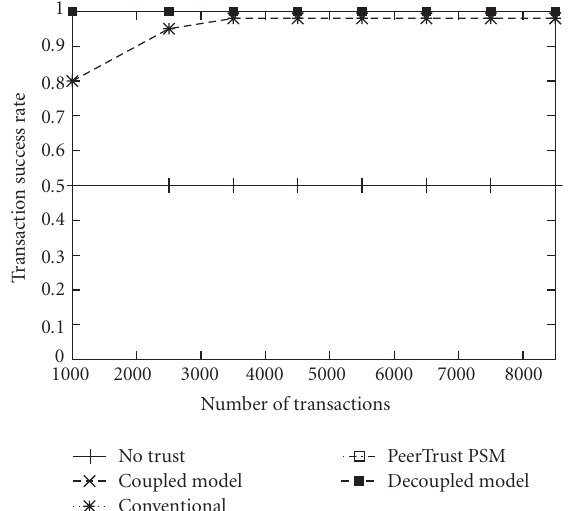
Figure 4: Trust computation error in a network with varying mali- cious rate of strategic